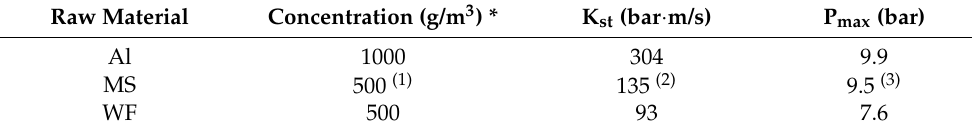
Table 1. Dust characterisation.